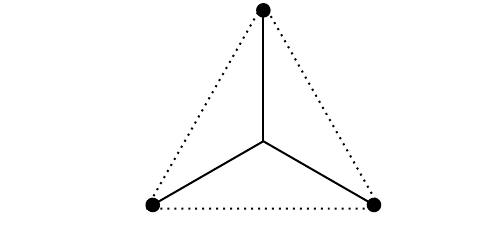
Figure 1: A Steiner minimal